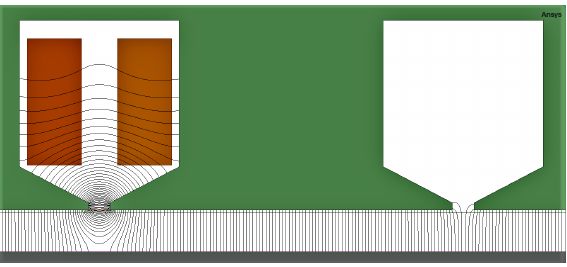
Figure 7. Flux lines inside energized and not energized slot (slot opening b so = 6 mm). Even if not shown in the figure, the magnetic structure is symmetrical with respect to the energized slot